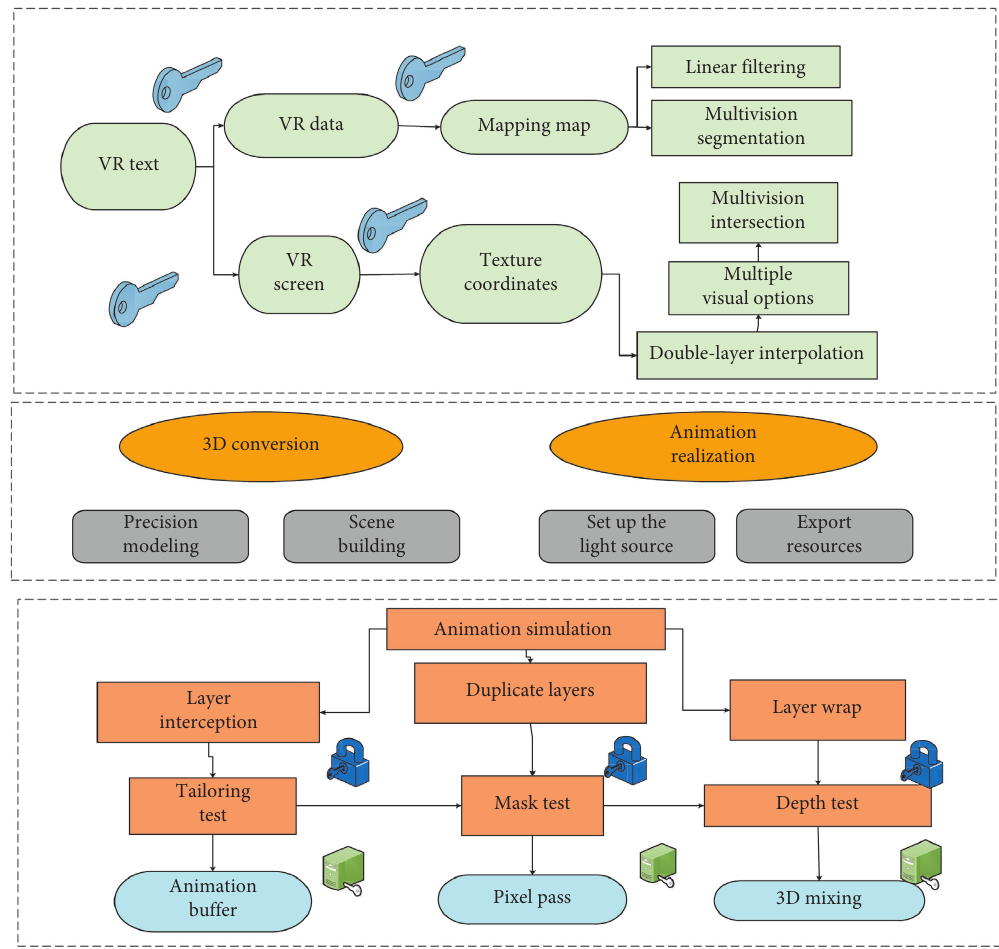
Figure 3: Multivisual animation character 3D model framework based on VR